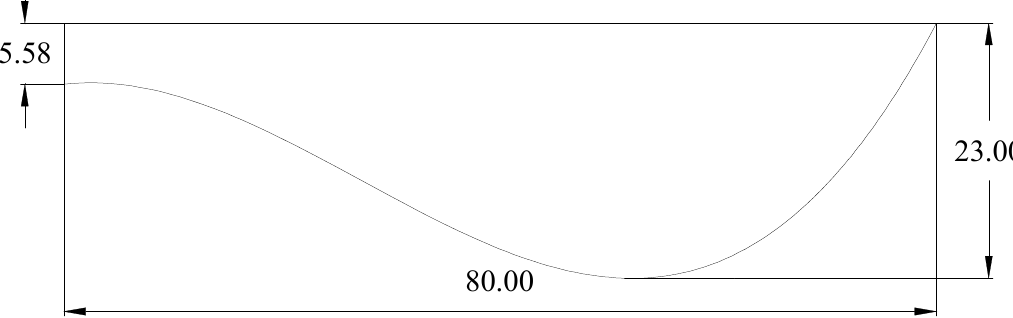
Figure 3. Biomimetic goat hoof track shoe section structure.